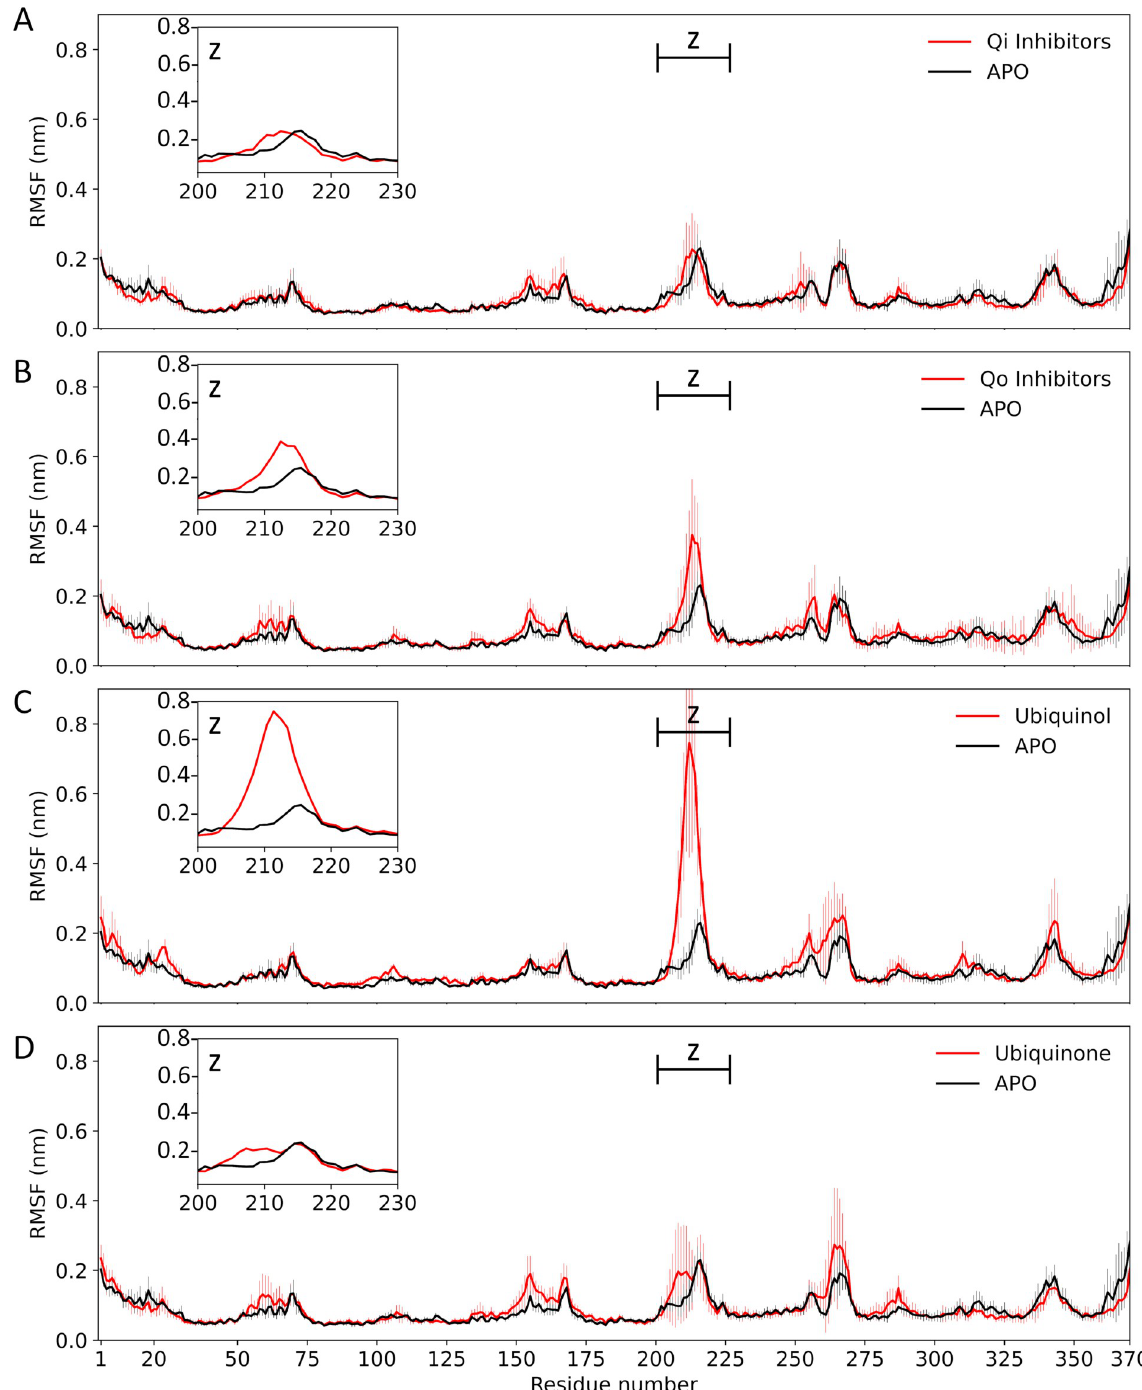
Fig 5. Root mean square fluctuation of cytochrome b backbone in presence of Qi inhibitors (panel A), Qo inhibitors (panel B), and two substrates (Ubiquinol in panel C and Ubiquinone in panel D) compared to the apo-form. The upper left zoom plot highlights the root mean square fluctuations between residue L200 and residue